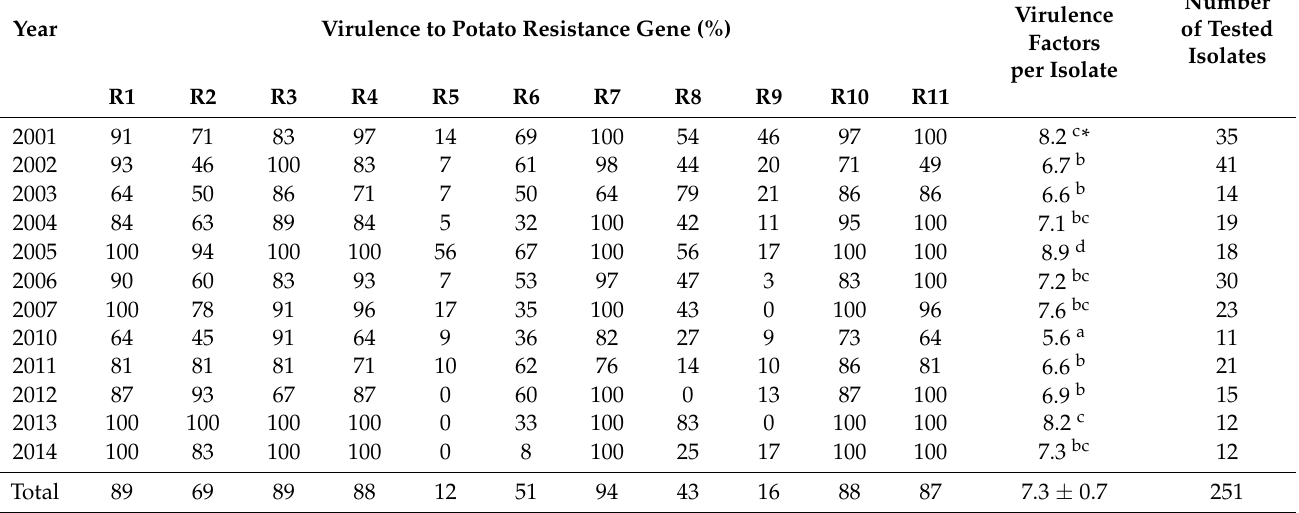
Table 1. Race frequencies among isolates, average number of virulence factors per isolate and average ± SE number of isolates in different years in P. infestans collected from breeding fields in Estonia during 2001–2007 and 2010–2014.